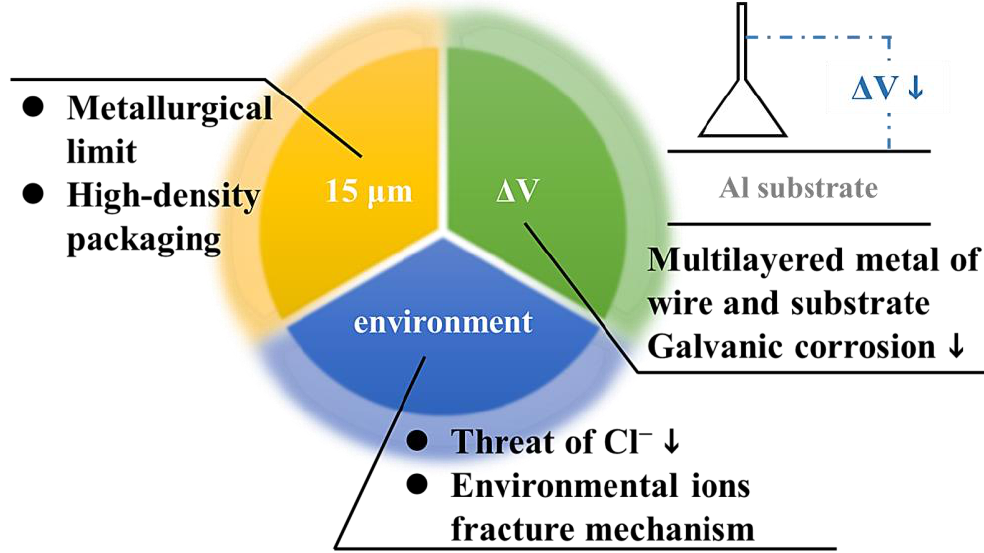
Figure 14. Summary of the study results.